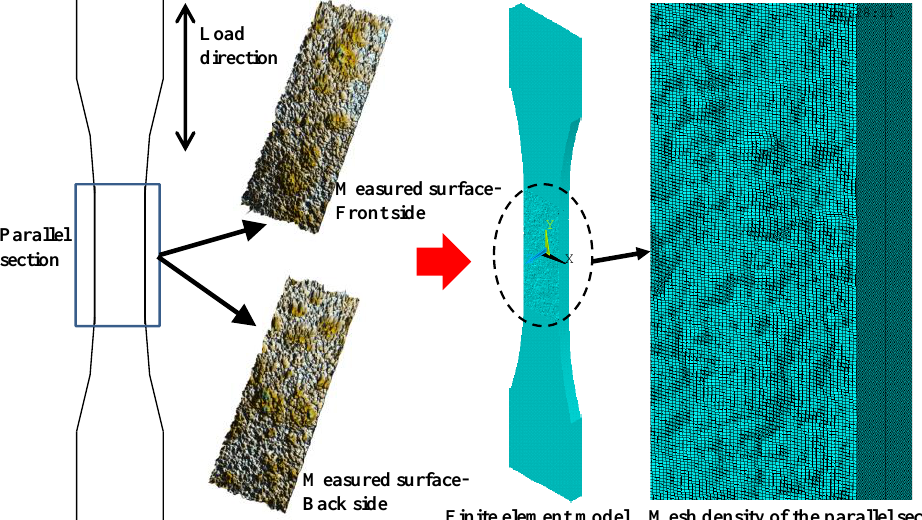
Figure 6. Reproduction process of the surface morphology characteristics of corroded steel plates in the finite element models.